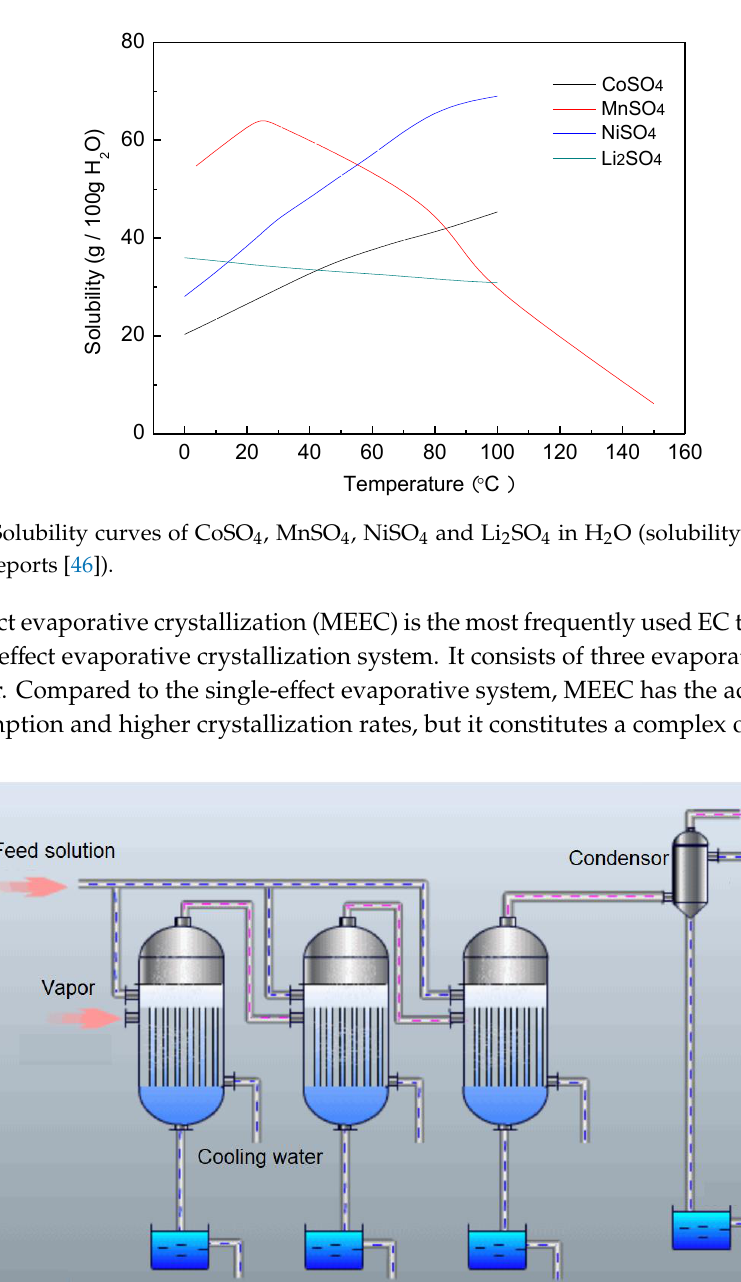
Figure 5. Schematic diagram of a triple effect evaporation crystallization system.